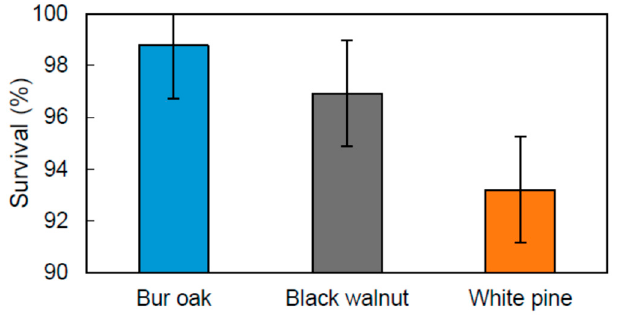
Figure 3. Species effect on survival rate ( p = 0.05) in an agricultural riparian buffer. Vertical bars represent standard error of the difference (SED).